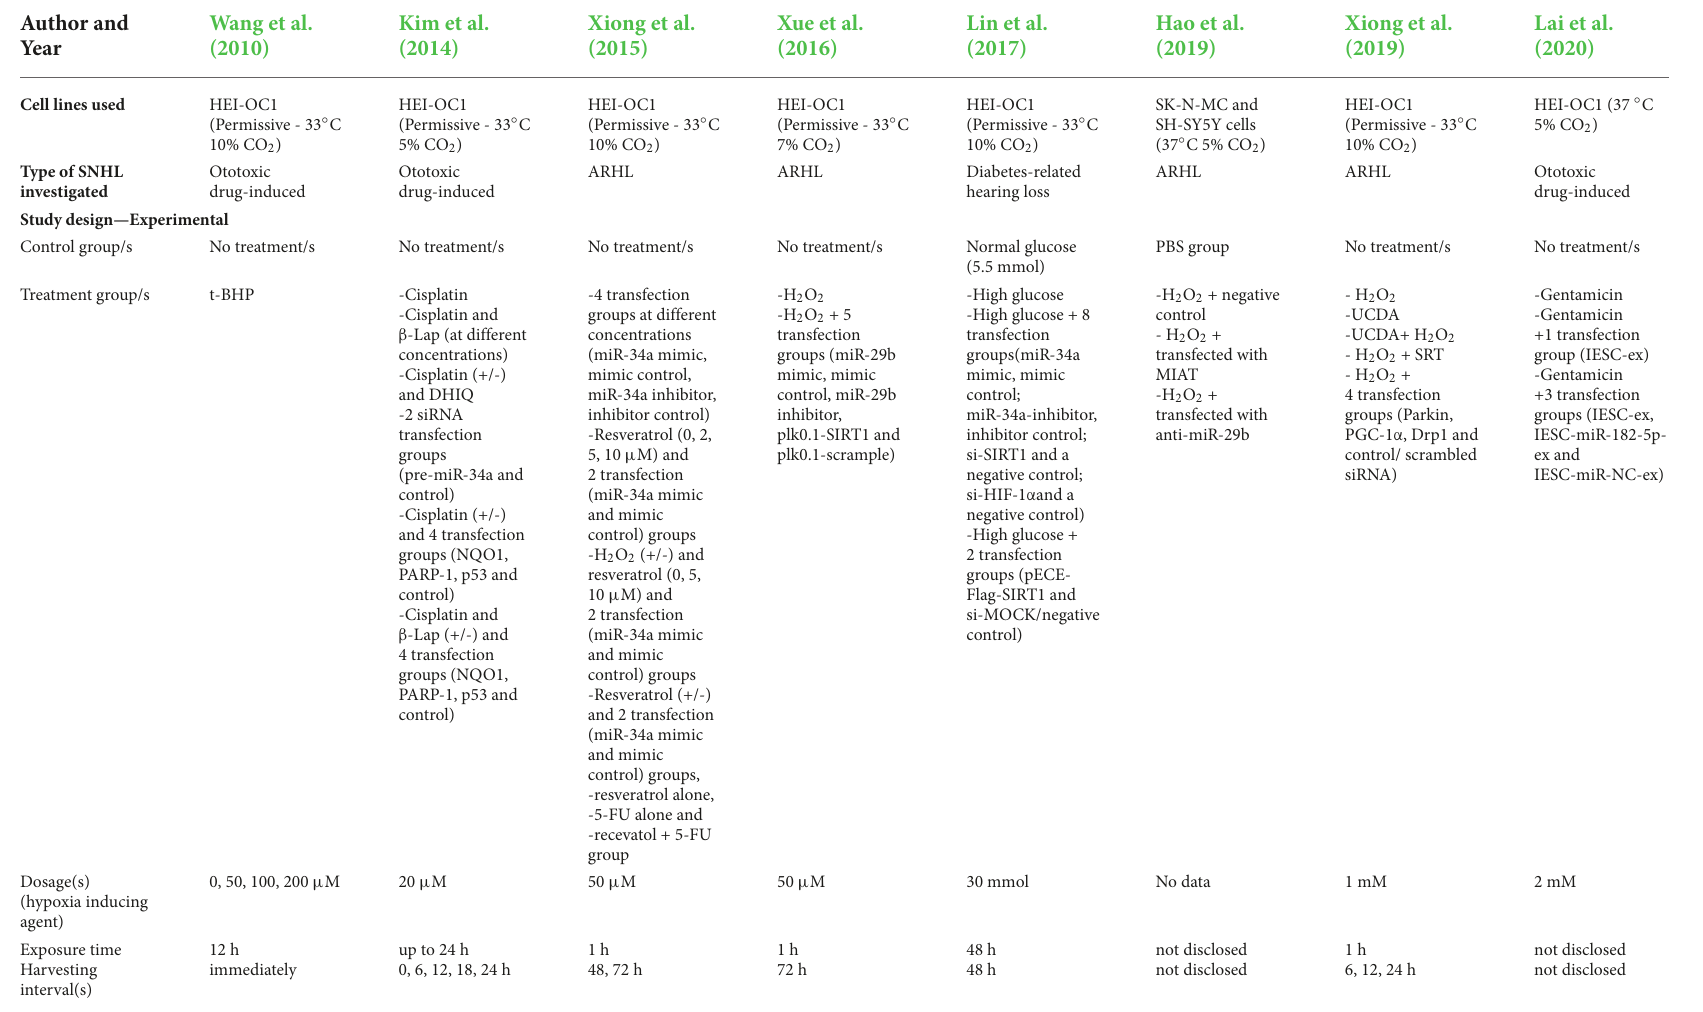
TABLE 1 Characteristics of the included in vitro cell